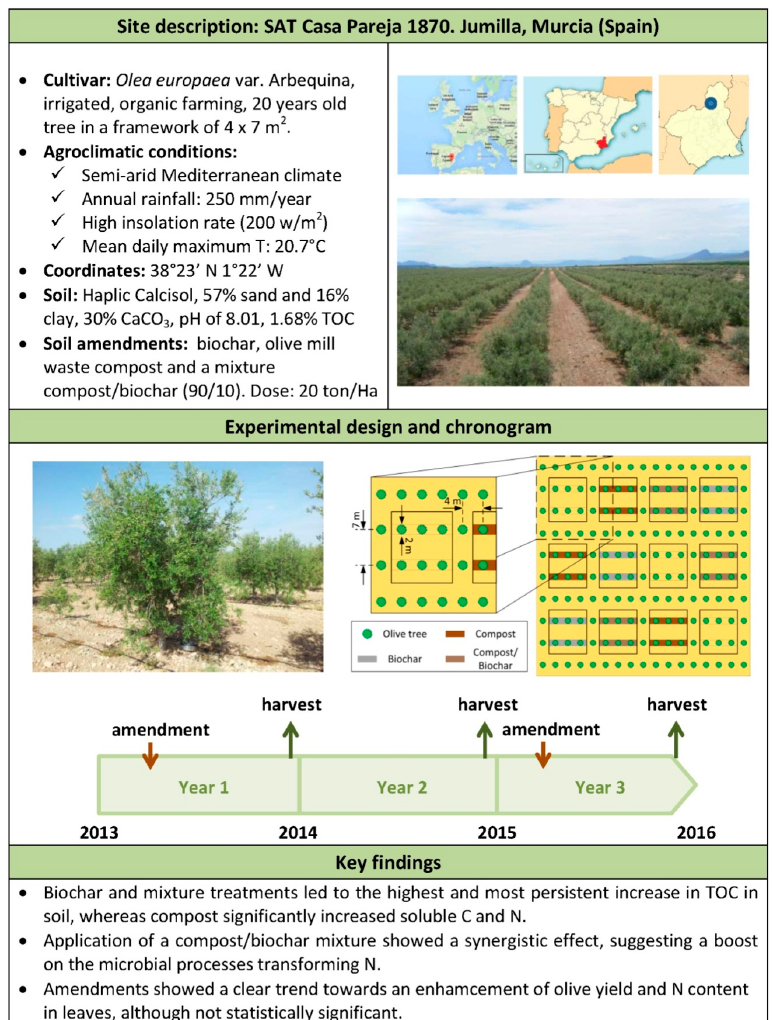
Figure 1. Description of the field scale experiment at Murcia (Spain): organic olive orchard.